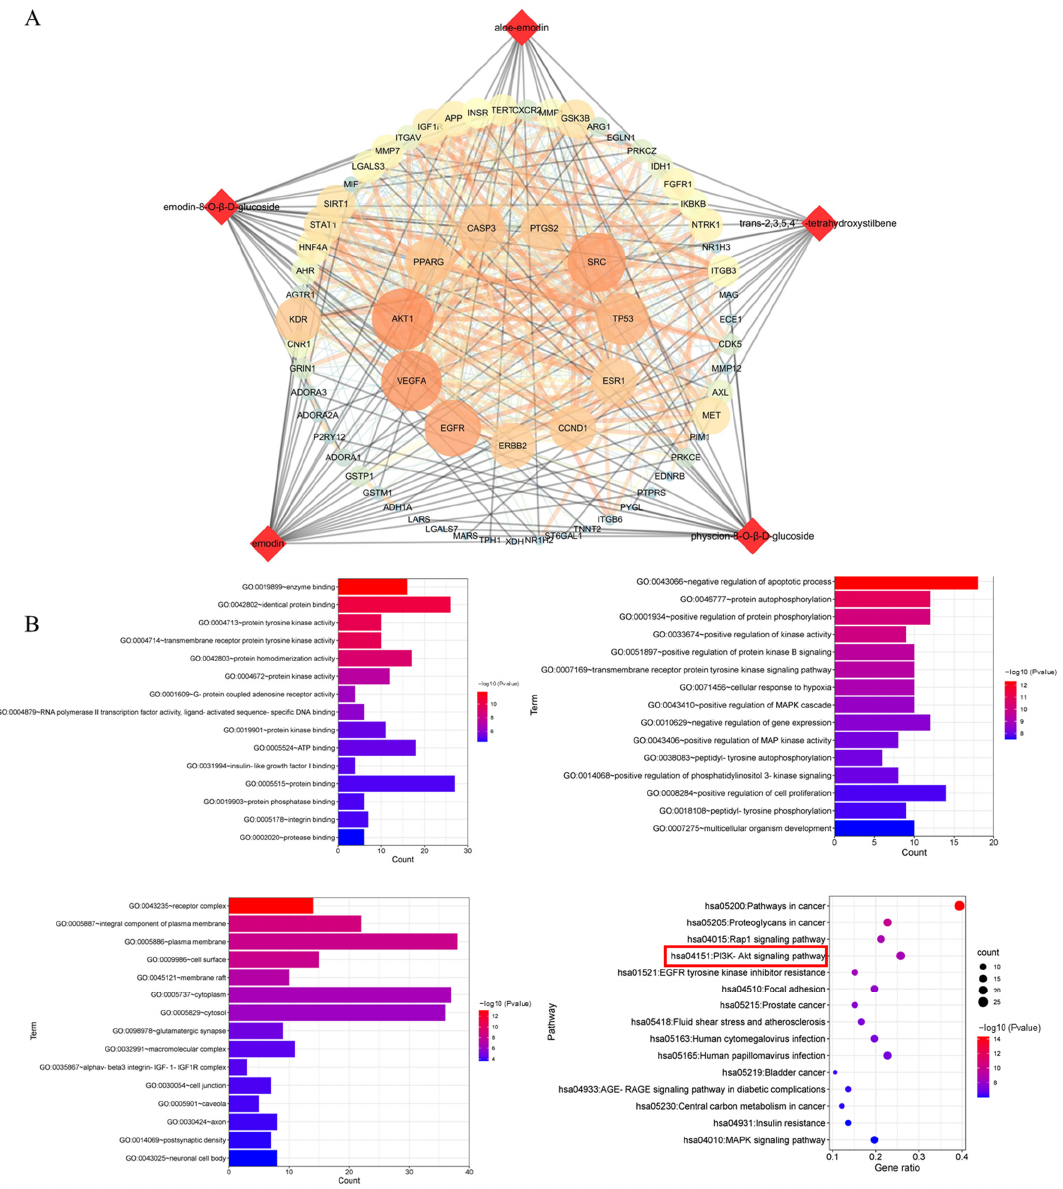
Figure 5. Network analysis of the five compounds absorbed into the blood after treatment with PM. ( A ) Compound target and liver injury target networks. Round nodes represent targets; red diamond nodes represent compounds. ( B ) GO analysis includes biological process and enriched KEGG pathways. The red box indicated the pathway most likely to be closely associated with liver injury.